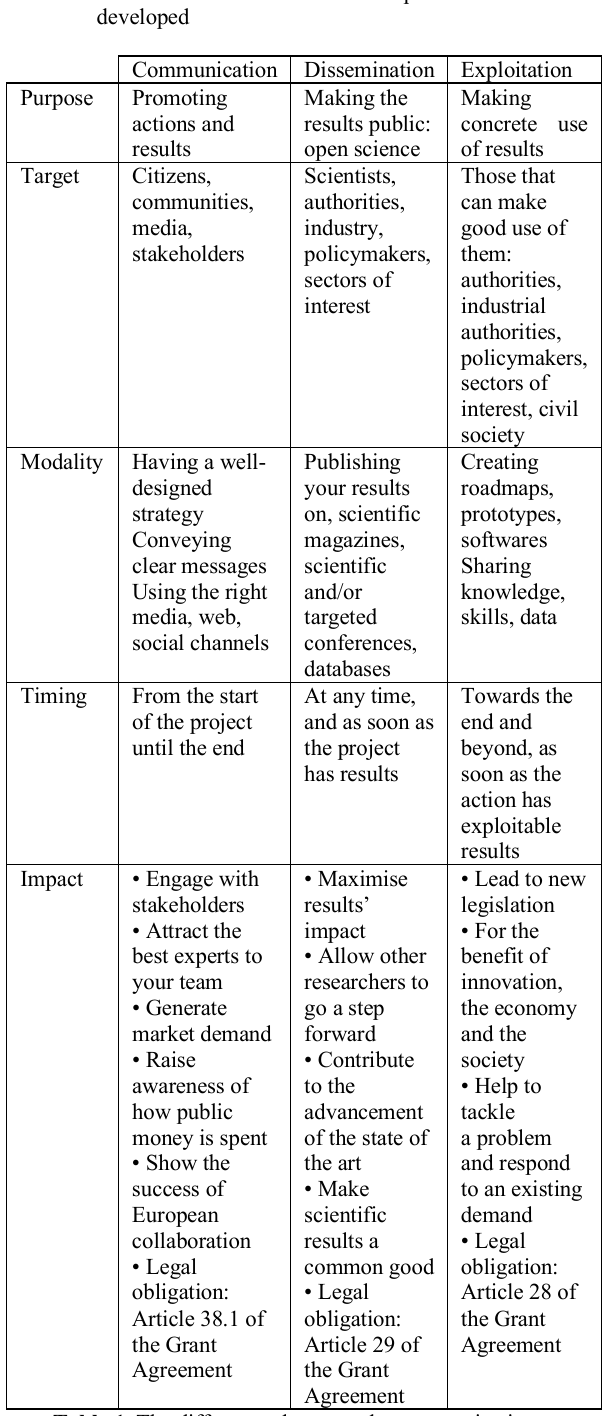
Table 1. The differences between the communication, dissemination, and exploitation activities of a research project, according to European Union Grant Agreement (EU,